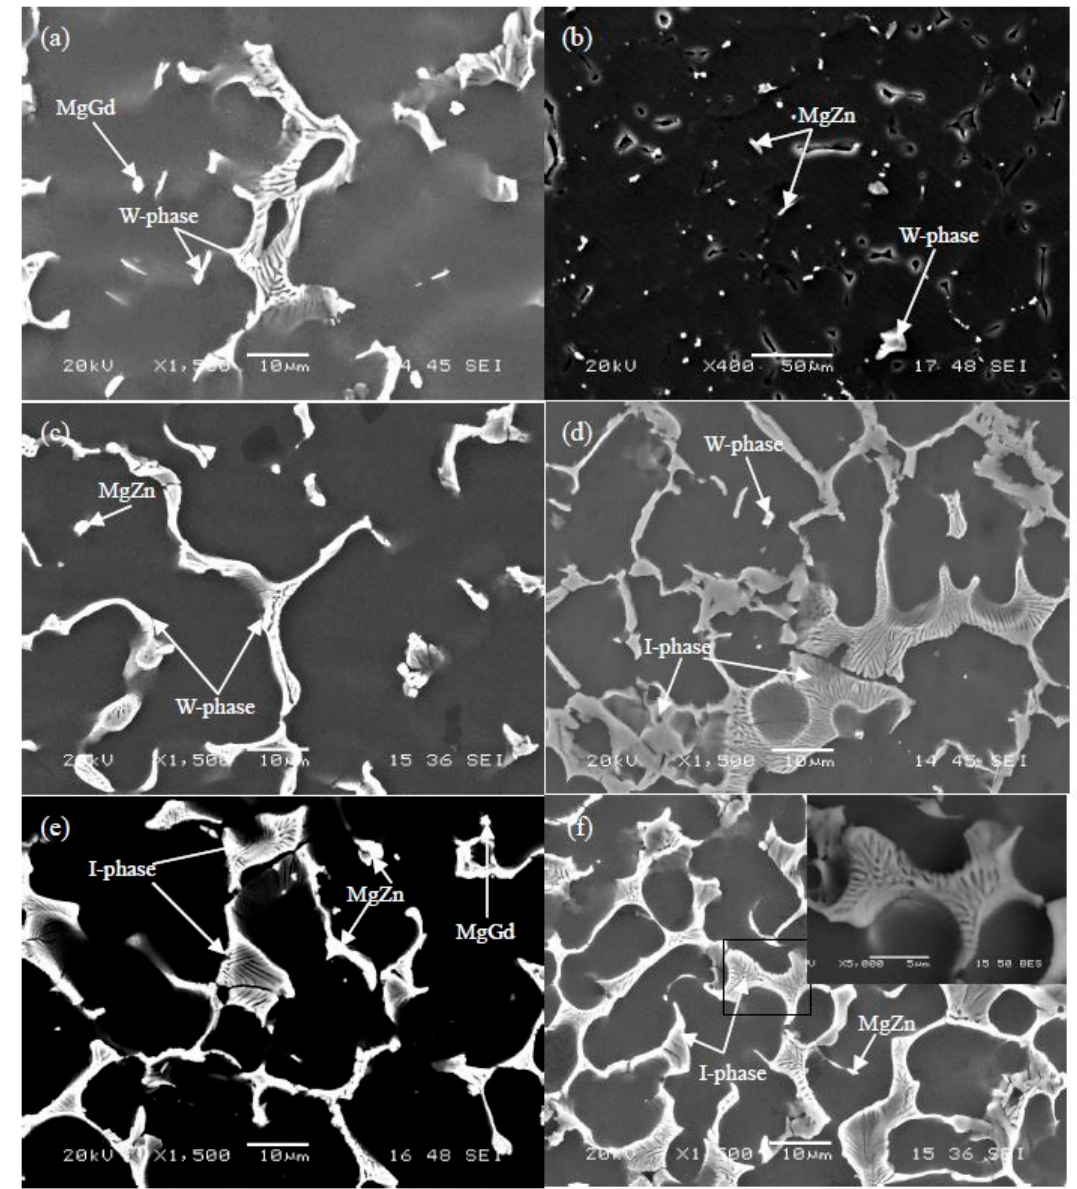
Figure 11. SEI of Mg-Zn-Gd alloys (Zn/Gd ratio, sample No.): ( a ) Mg-0.5Zn-2Gd (0.25, sample 45), ( b ) Mg-1Zn-0.1Gd (10, sample 40), ( c ) Mg-3Zn-0.3Gd (10, sample 23), ( d ) Mg-5Zn-0.5Gd (10, sample 7), ( e ) Mg-10Zn-1Gd (10, sample 1), ( f ) Mg-10Zn-0.4Gd (25, sample 2), and the inset of ( f ) is BSE of rectangle area.